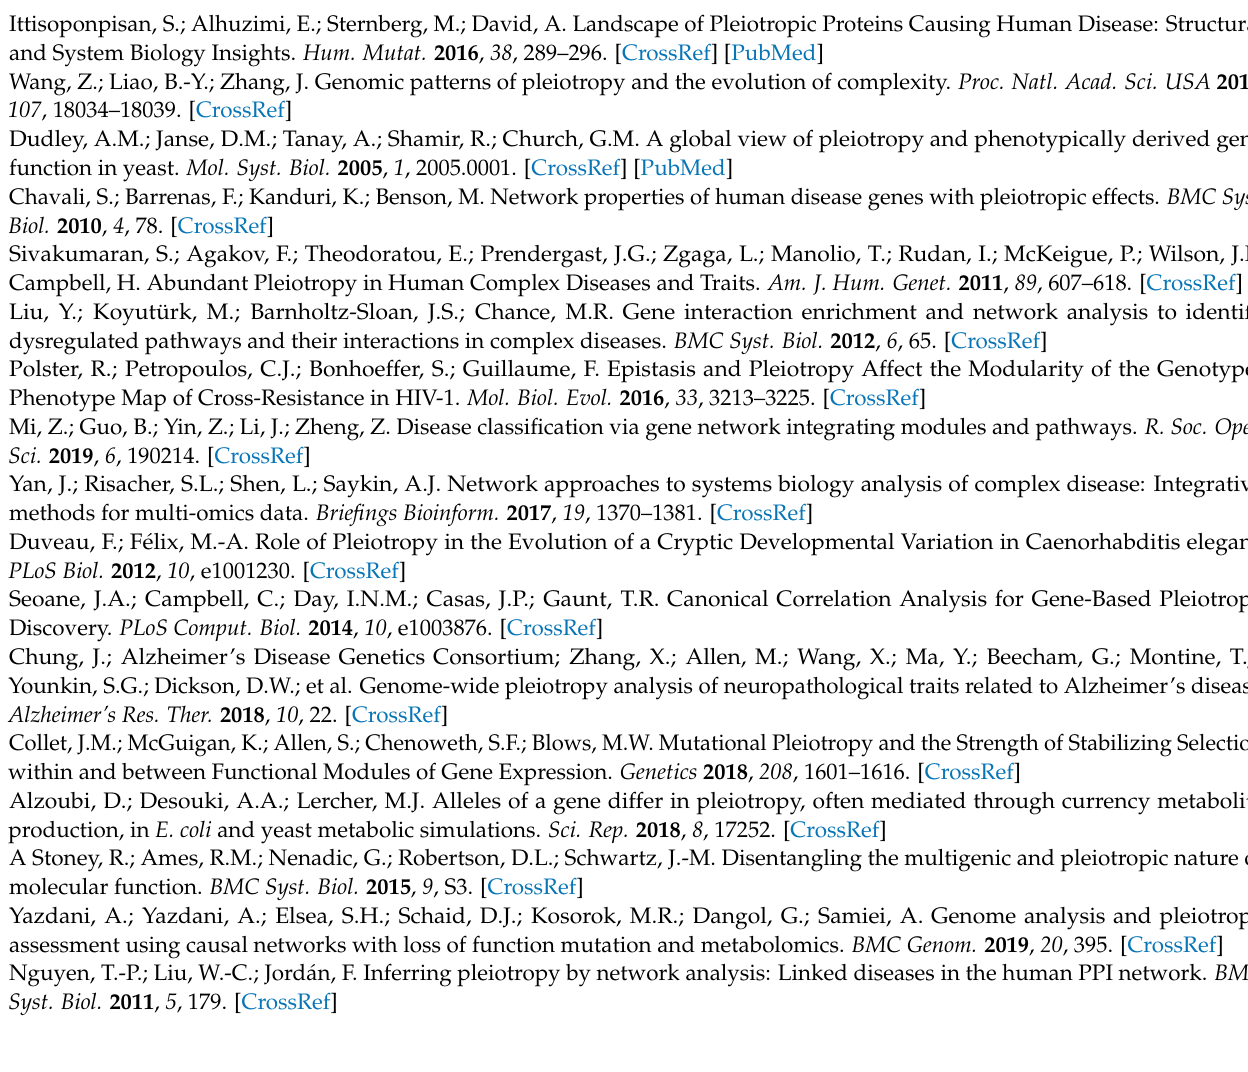
Figure S3. Relations of sPS values to feedback loops in KEGG network; Figure S4. Relations of sPS value in random BA network; Figure S5. Original KEGG network with | V | = 1659, | A | = 7964; Table S1. KEGG network dataset consists of 1659 nodes and 7964 interactions; Table S2. KEGG-HPO associated [92]; Table S3. KEGG functional importance genes; Table S4. KEGG functional importance genes